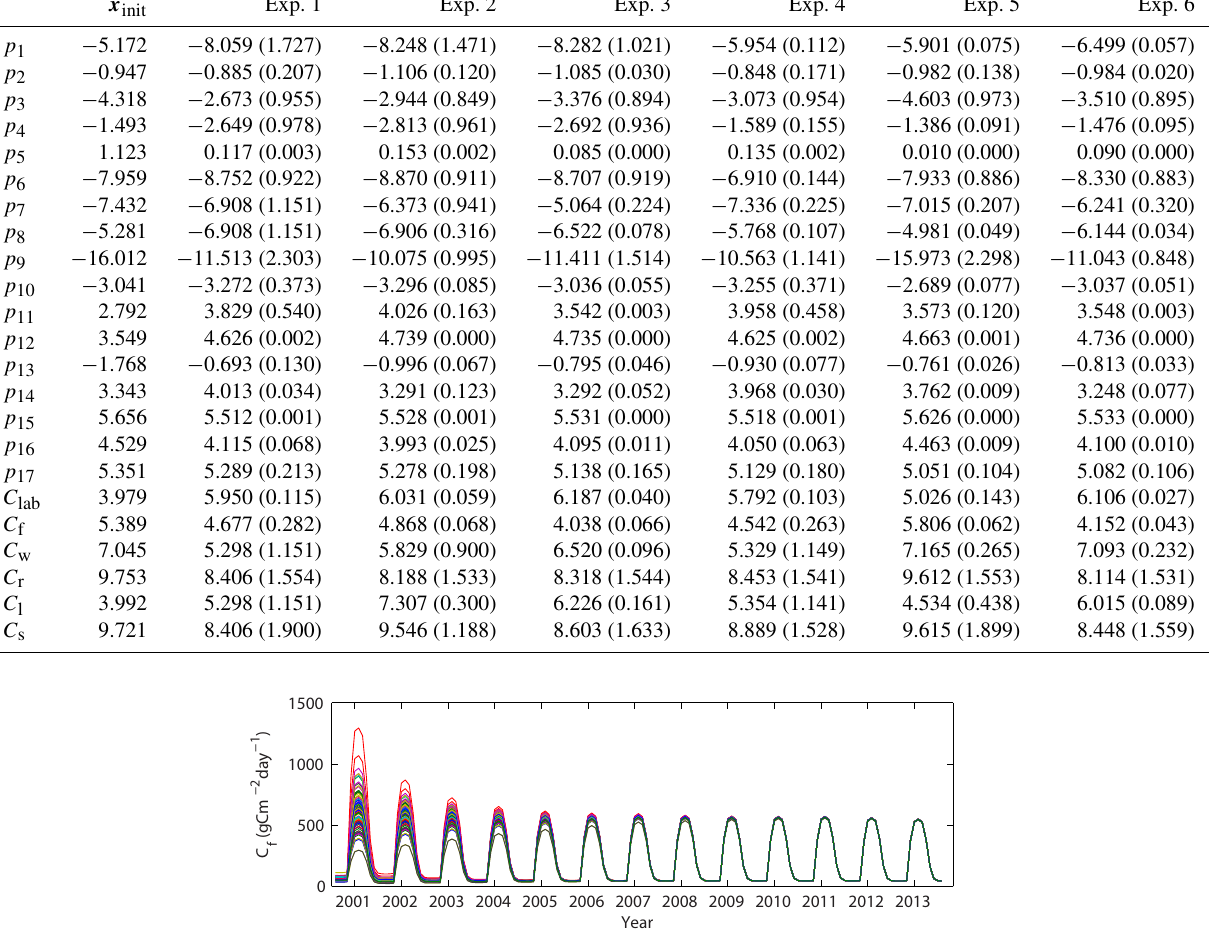
Figure 13. Pseudo-periodical seasonal cycle for DALECv2. Using a given set of parameters and initial values for C w and C s , 100 DALECv2 runs are performed using random initial values for C lab , C f , C r , C l . The plot shows the 100 trajectories for C f